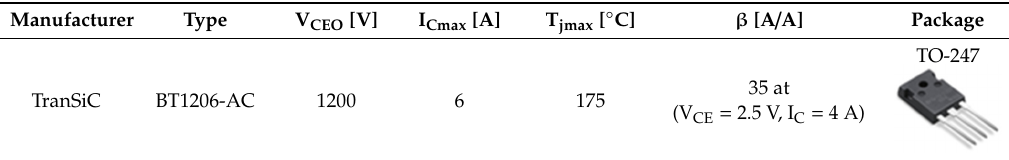
Table 1. Parameter values of the BT1206-AC